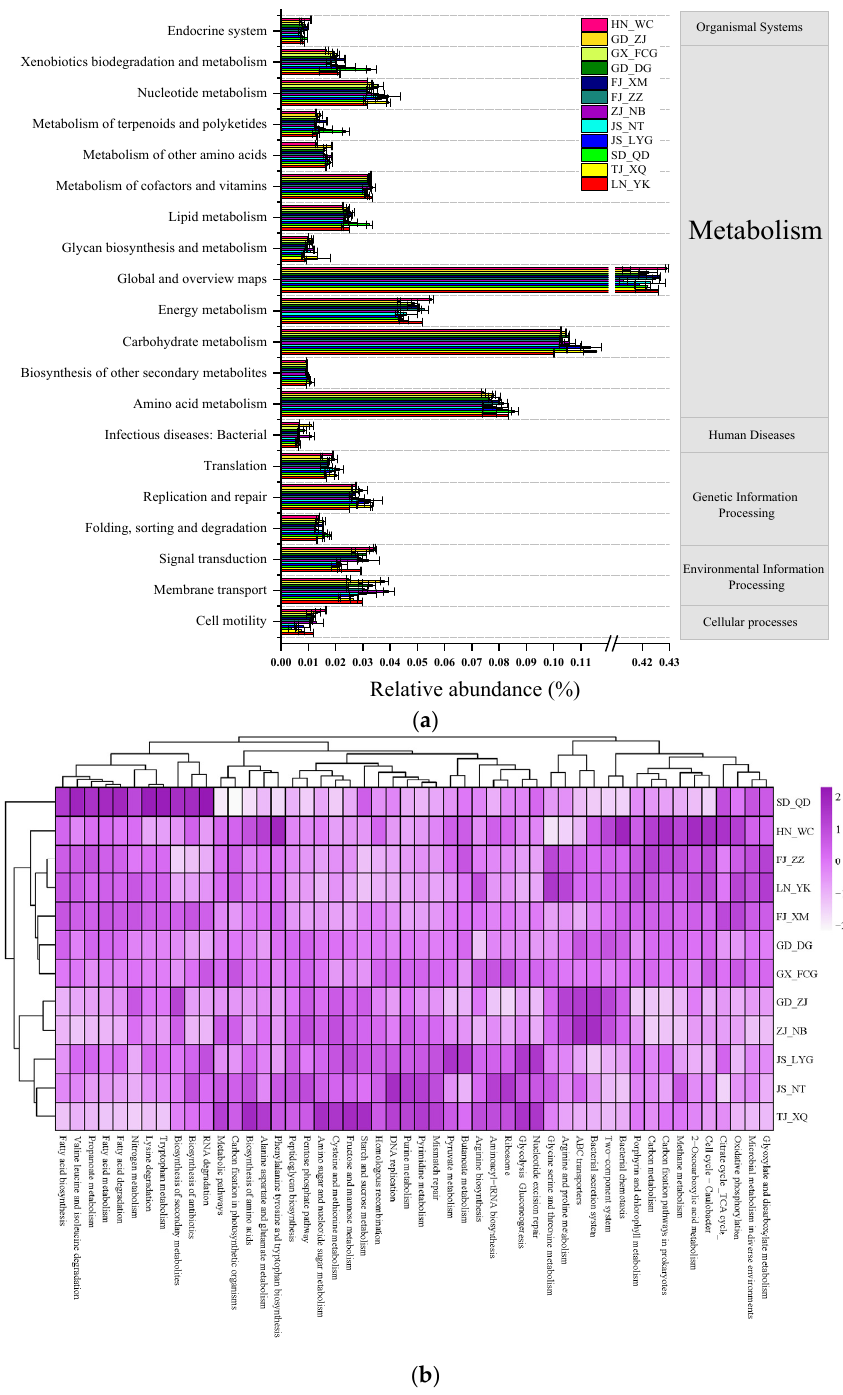
Figure 5. Predictive functional profiling of the bacterial communities in the gut of L. vannamei analyzed by Tax4Fun based on the KEGG database (mean, n = 3). ( a ) Only genes with an average relative abundance (at level 2) >1% are shown here. ( b ) Heat map showing the predictive functional profiling of the top 50 KEGG pathways (at level 3). Relative percentage values for the KEGG pathways are indicated by color intensity.